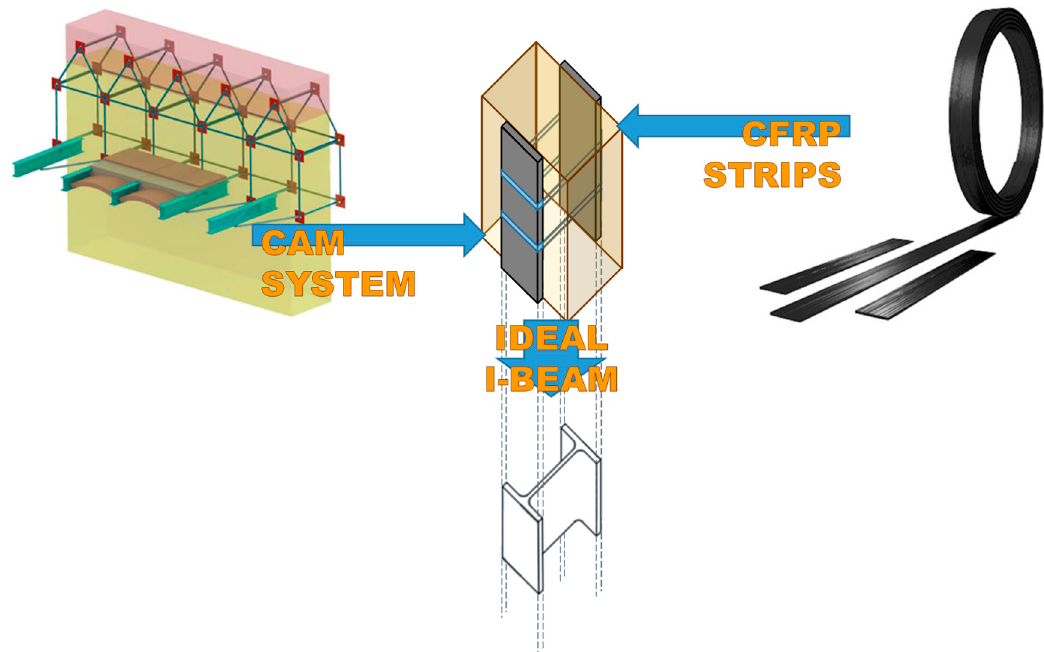
Figure 4. The transverse connections between the FRP strips give rise to an I-beam behavior [1].